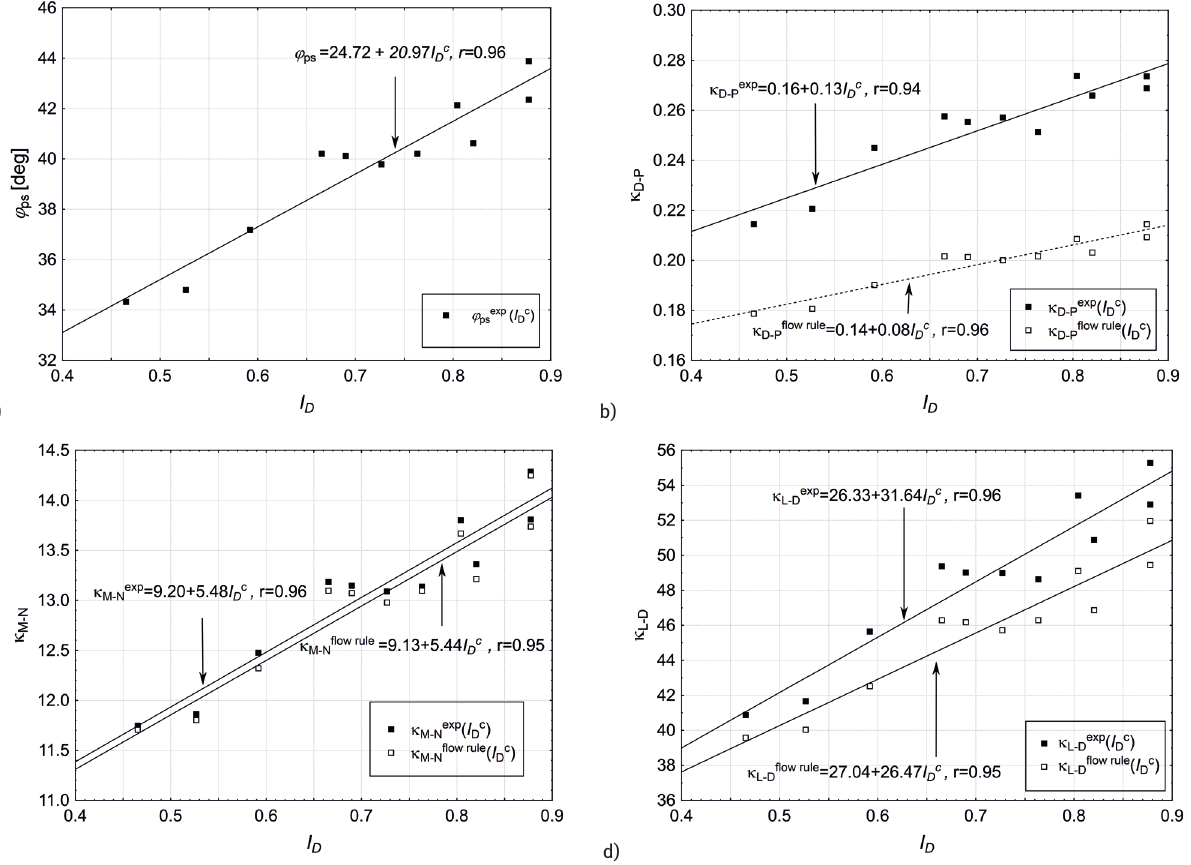
Figure 17: Parameters of Mohr–Coulomb (M-C), Drucker–Prager (D-C), Matsuoka–Nakai (M-N) and Lade–Duncan (L-D) failure criteria depending on soil relative density: (a) friction angle j , (b)–(d) comparison of κ measurement) and Eqs. (25)–(27) (plane strain condition – Vikash and Prashant